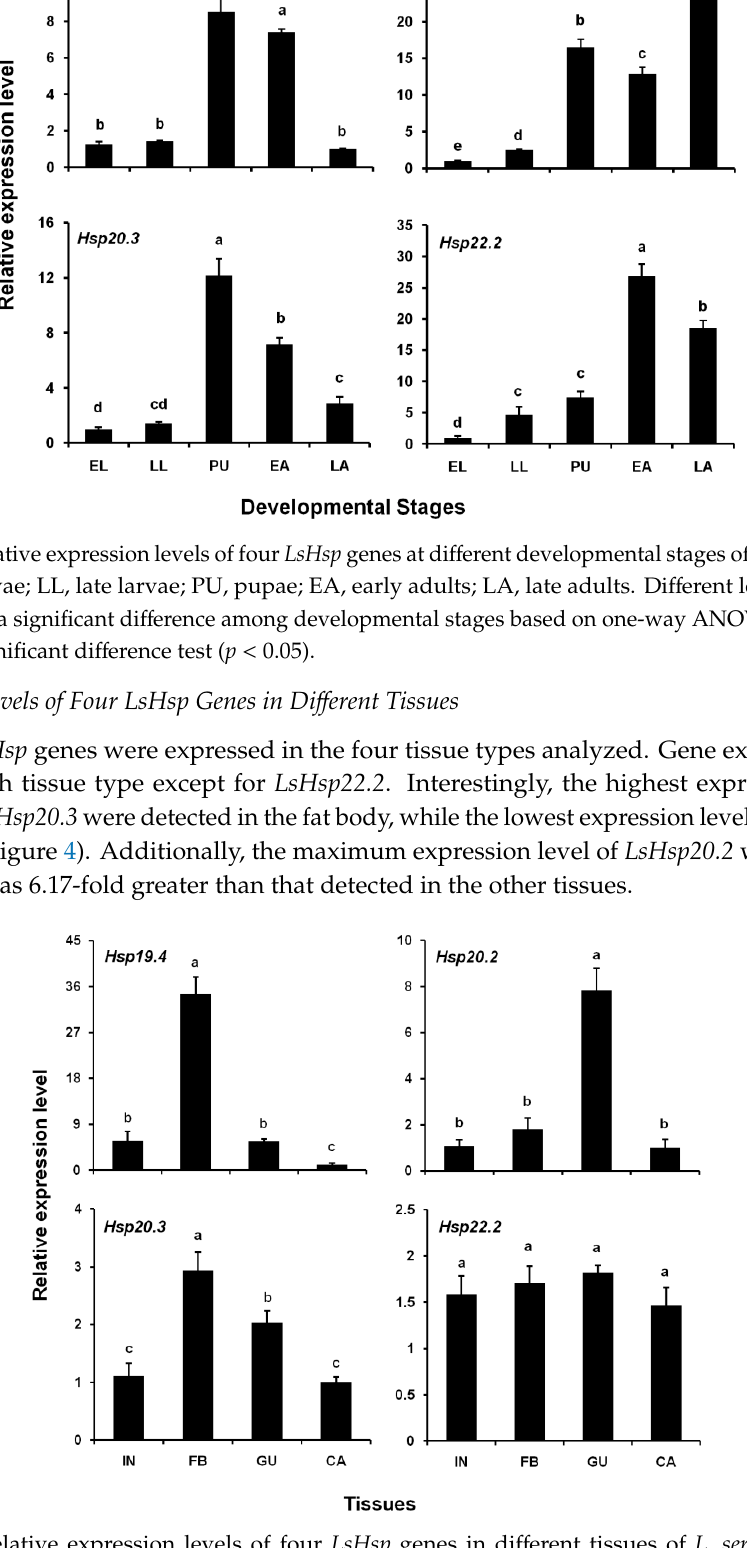
Figure 4. Relative expression levels of four LsHsp genes in different tissues of L. serricorne . IN, integument; FB, fat body; GU, gut; CA, carcass. Different letters above bars indicate a significant difference among tissues based on one-way ANOVA followed by a least significant difference test ( p < 0.05).